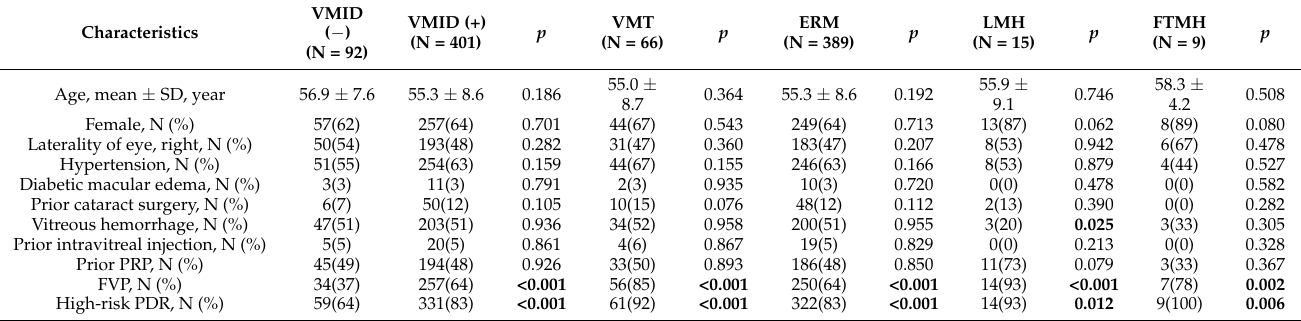
Table 2. Baseline characteristics of proliferative diabetic retinopathy.